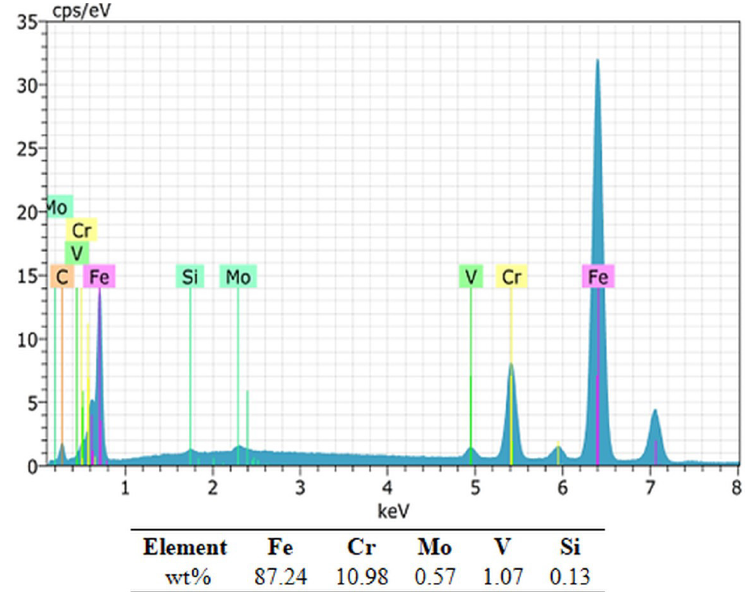
Figure 7. Spectrogram of X22CrMoV12-1 alloy in point